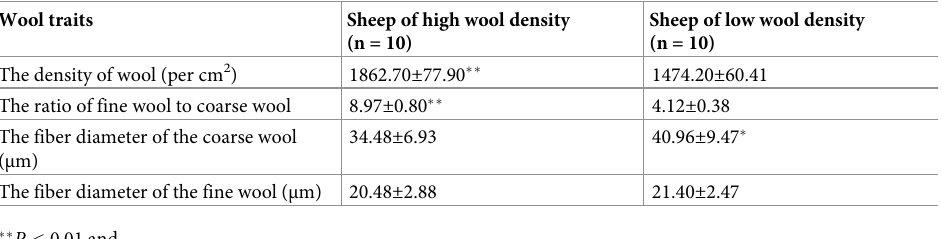
Table 1. Comparison of the wool traits of the Hetian sheep. Wool